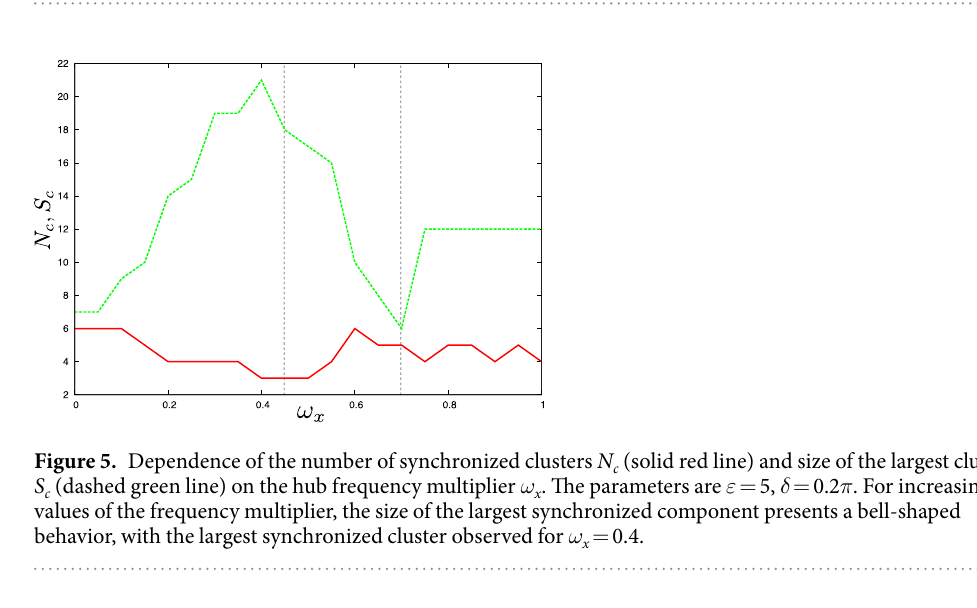
Figure 4. λ s (as in Eq. (5)) as a function of the frequency mismatch ω – ω 0 and the strength C of the mean field for the case A = B = 1, α = β = 0.3 π . The synchronous solution is stable if λ s < 0. The black line represents the stability border ( λ s = 0) for γ = 0.2 π ( a ) and γ = 0.6 π ( b ). The red crosses in ( a ) and ( b ) show the parameters used in Fig. 3a and b, respectively.